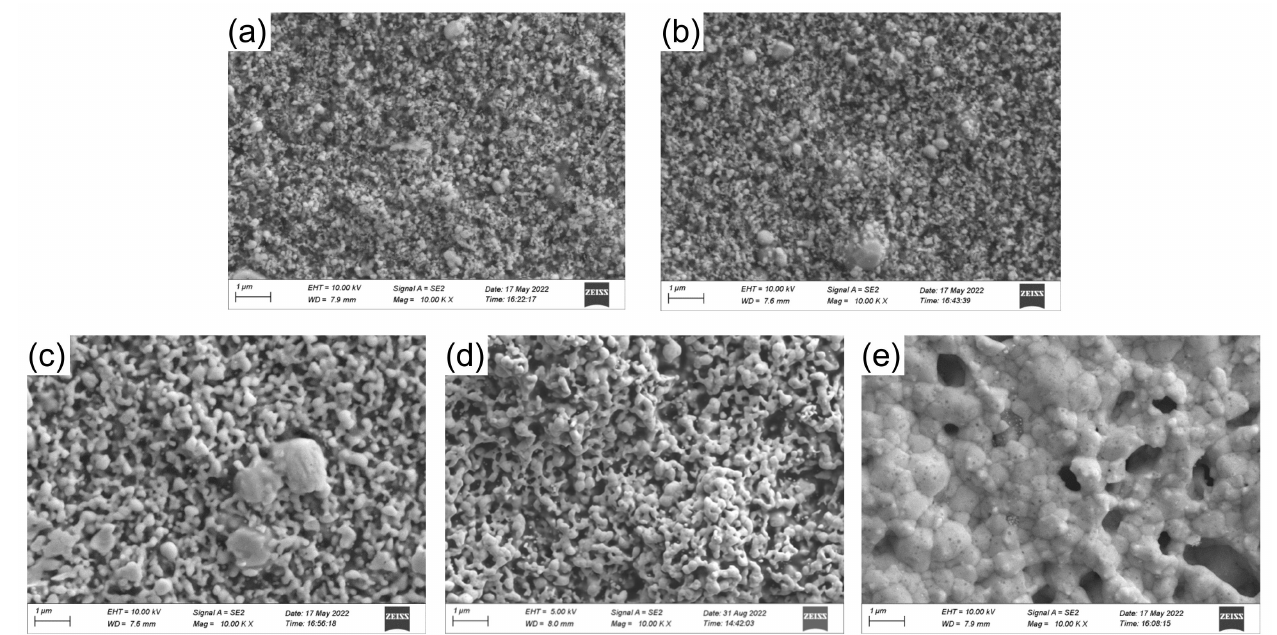
Figure 5. The SEM photographs of conductive pattern at different curing temperatures. ( a ) 200 ◦ C, ( b ) 250 ◦ C, ( c ) 300 ◦ C, ( d ) 320 ◦ C, ( e ) 350 ◦